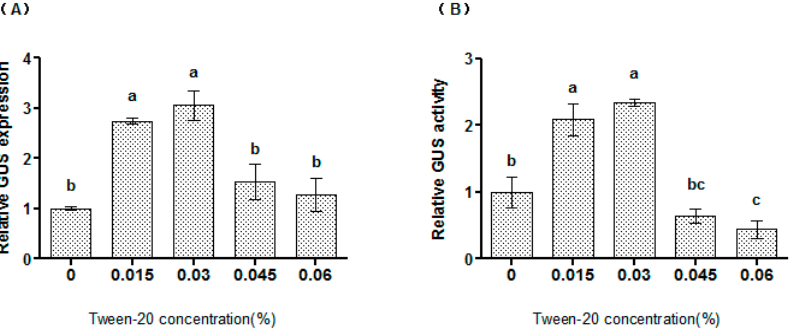
Figure 3. The effects of Tween-20 on syringe agroinfiltration efficiency by determination of GUS expression ( A ) and GUS activity ( B ). ( A ) Agroinfiltration efficiency analyzed by GUS expression. The expression of GUS in the control experiment (no Tween-20 was supplied) was used to normalize the expression of GUS at different concentrations of Tween-20; ( B ) The effects of Tween-20 on agroinfiltration efficiency were determined by GUS activity analysis. GUS activity at different levels of Tween-20 treatments was normalized by the level in the control. a, b, c means not sharing a common superscript differ significantly according to ANOVA Tukey’s test ( p < 0.05).